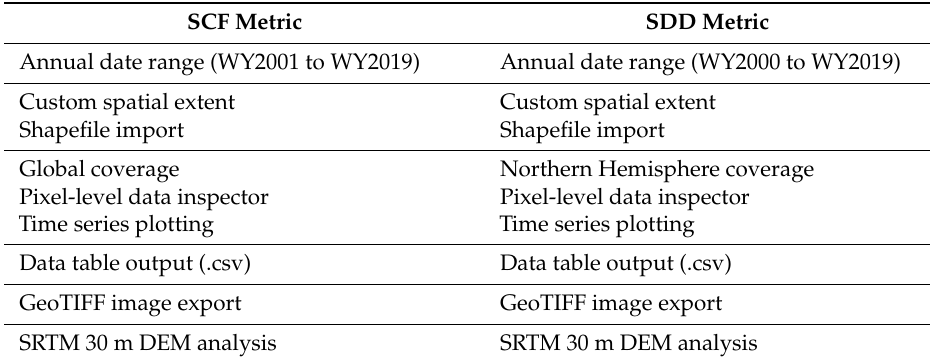
Table 4. SnowCloudMetrics app and script custom functionality.